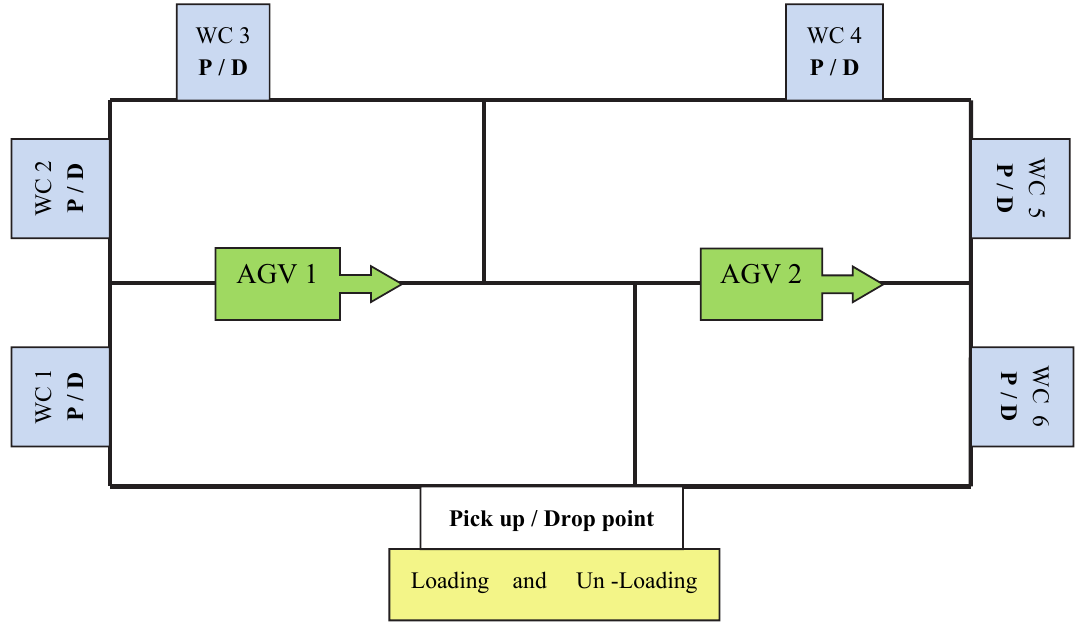
Fig. 3 The FMS layout 1 comprised of 6 numbers of work center and one loading and unloading center. The Grey wolf algorithm is run for 100 iterations and the population size of the grey wolves is taken 30. Parameter adjustment of grey wolf algorithm for above problem is carried out by considering